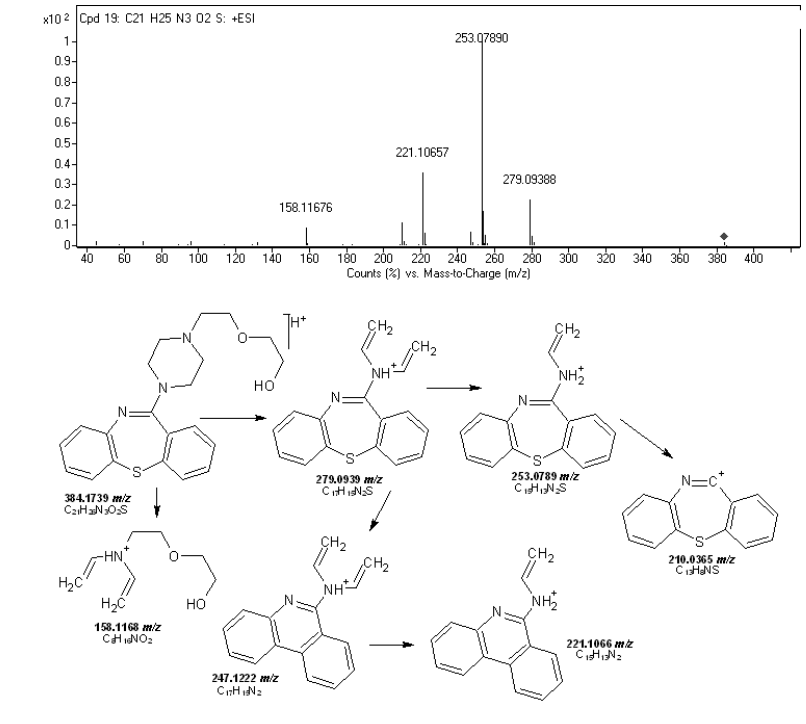
Figure 2. Q-TOF MS/MS spectrum and fragmentation pathway of quetiapine.